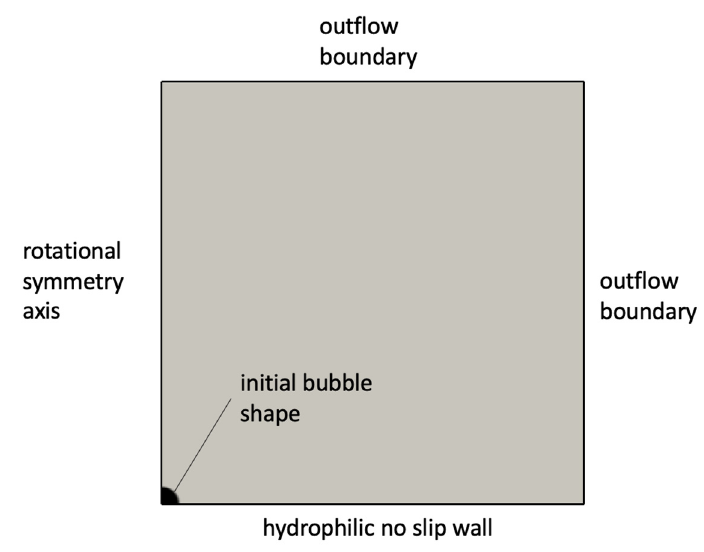
Figure 4. Setup of microlayer formation simulations.